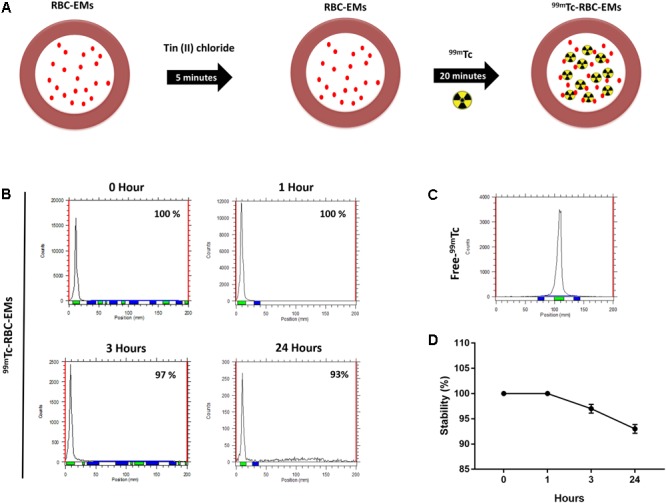
Radiochemical purity and stability of 99mTc-labeled RBC-EMs (A) Illustration of the procedure for labeling RBC-EMs with 99mTc. (B,C) The counts of radioactivity for 99mTc and 99mTc-RBC-EMs were measured by thin layered chromatography. (D) Serum stability was determined by the percent change in the radiochemical purity of 99mTc-RBC-EMs for the indicated time periods. The values are expressed as mean ± SD.